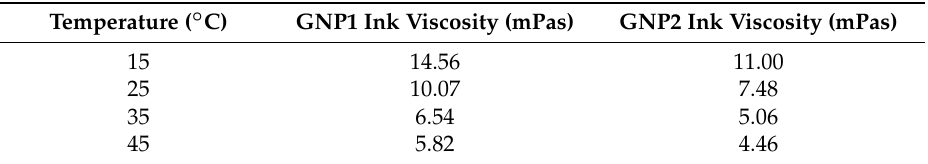
Table 1. The viscosity values of the graphene inks.